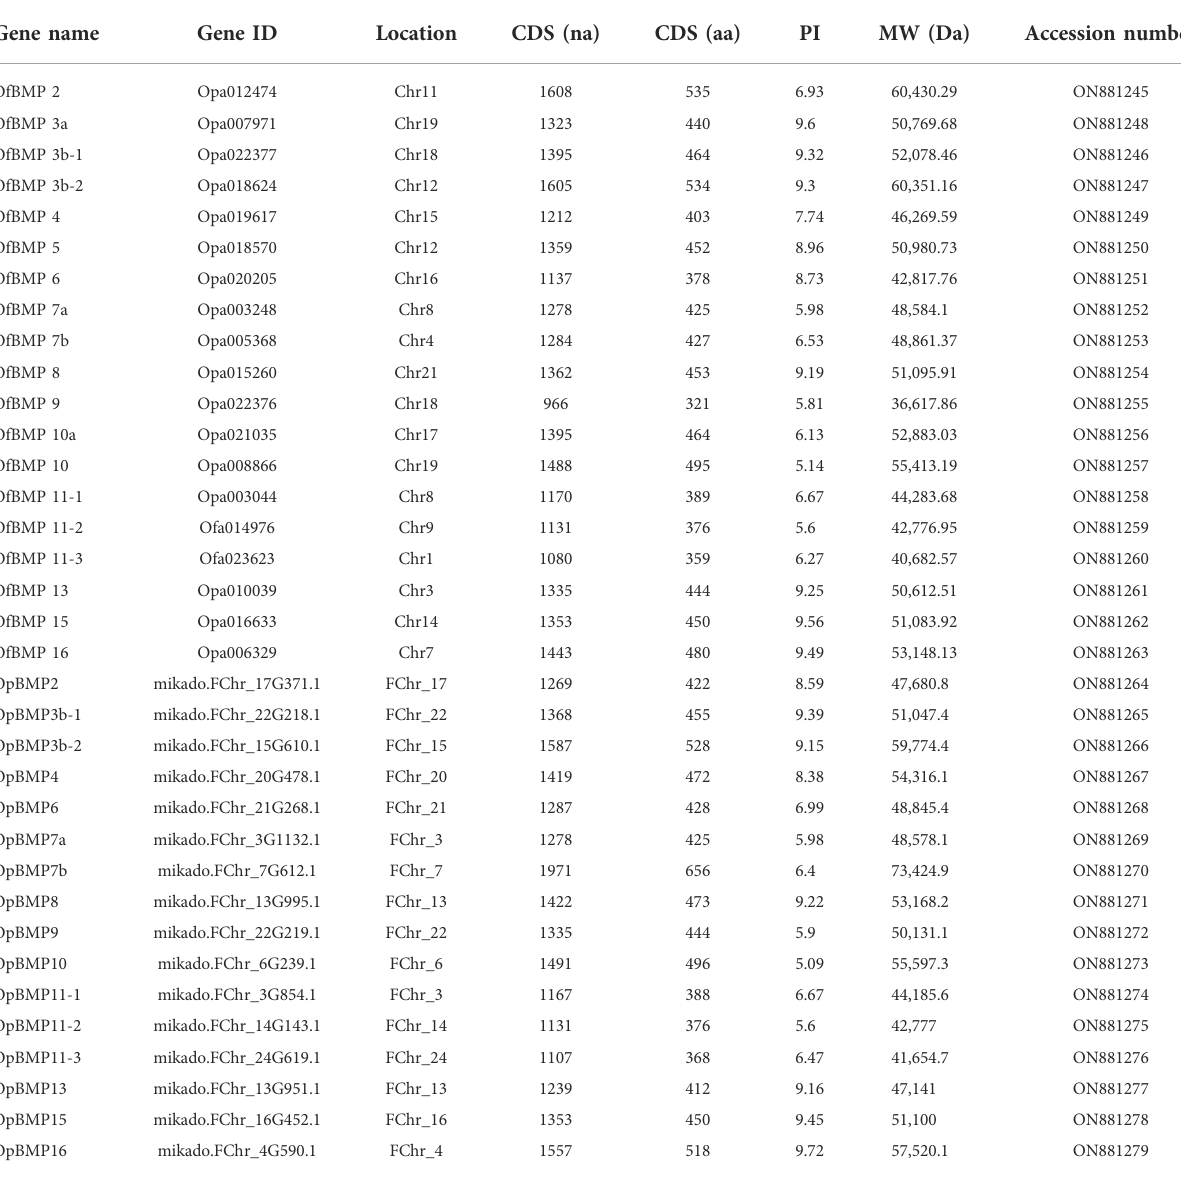
TABLE 1 Summary of the characteristics of BMP genes in O. fasciatus and O. punctatus